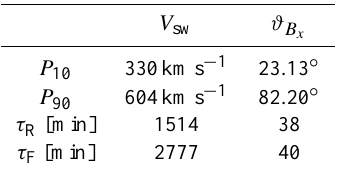
Table 4. Mean rise and fall times of V sw and ϑ B The 10th and 90th percentiles of V sw and ϑ B and P 90 .